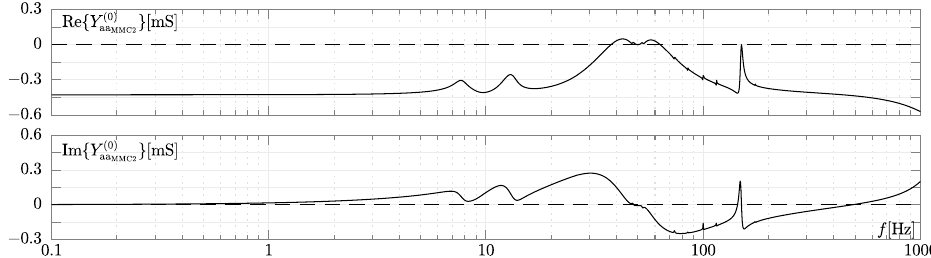
Figure 10. The admittances of the “a” phase of the DC - SLACK / Q type MMC 2 when the accurate HVDC link model is used. Upper panel: real part of the admittance [mS]. Lower panel: imaginary part [mS]. X-axis: frequency [Hz]. In the panels, the dashed lines denote null real and imaginary